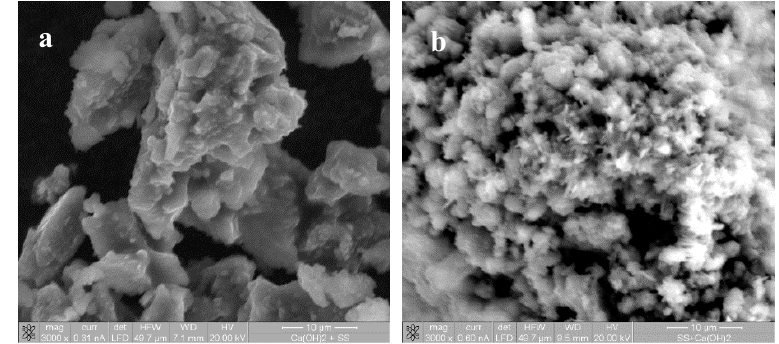
Figure 9. X-ray diffraction patterns of NaSil solution and Ca(OH) 2 at different mixing times, dried at 60 °C and 50 mbar.